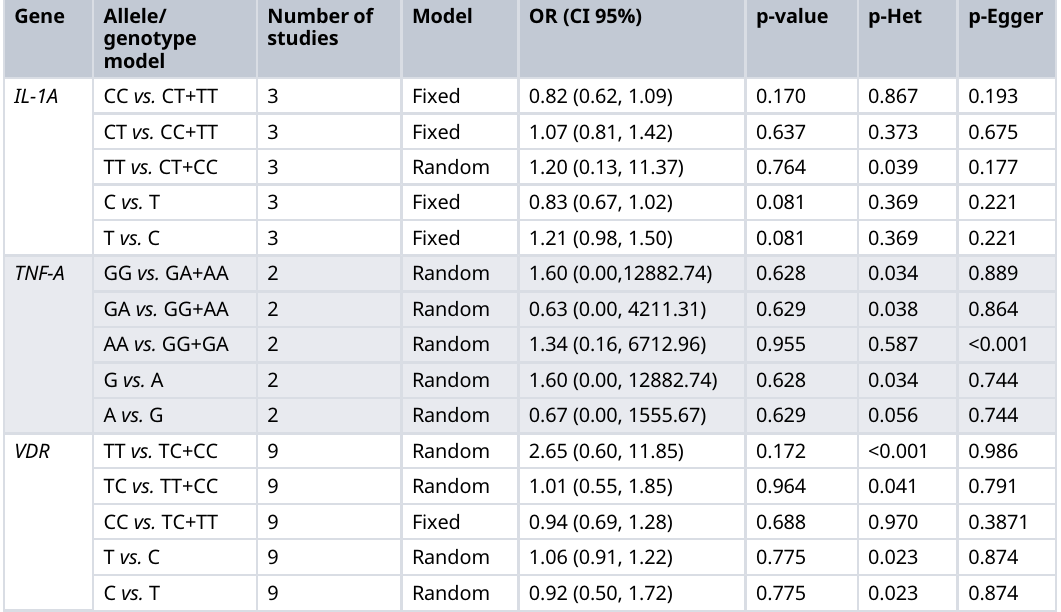
Table 2. Associations of genotypes and alleles of IL-1A -889C>T, TNF-A 238G>A, and VDR TaqI (rs731236) on